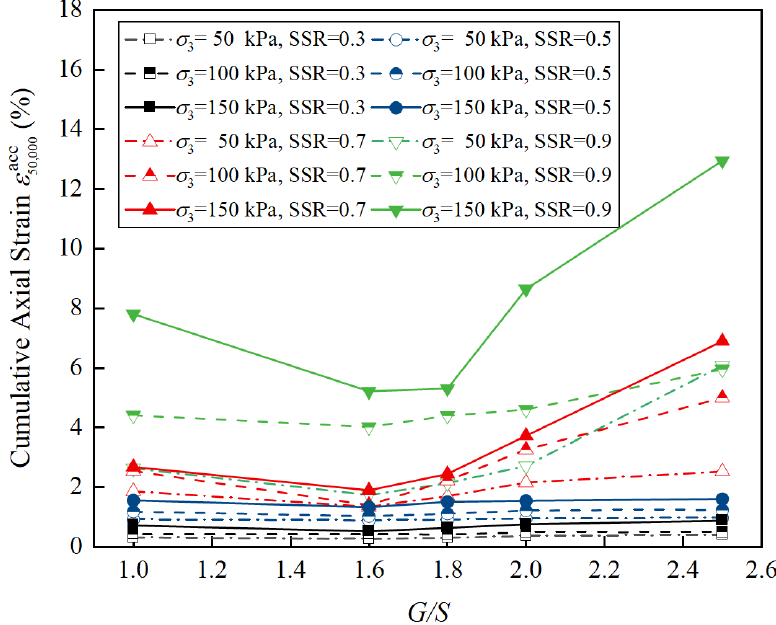
Figure 9. Laboratory-measured cumulative plastic strain at N = 50,000 versus G / S values of speci- mens.